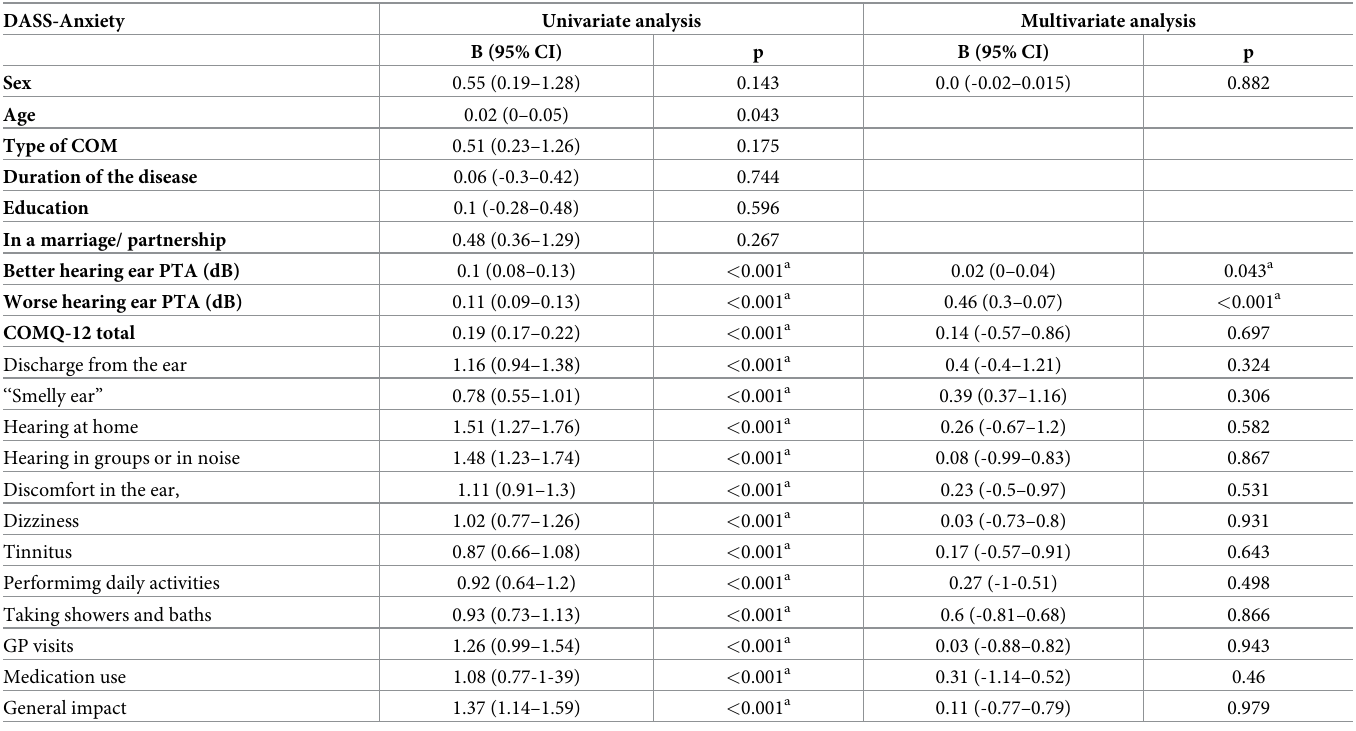
Table 5. Univariate and multivariable logistic regression for DASS-anxiety